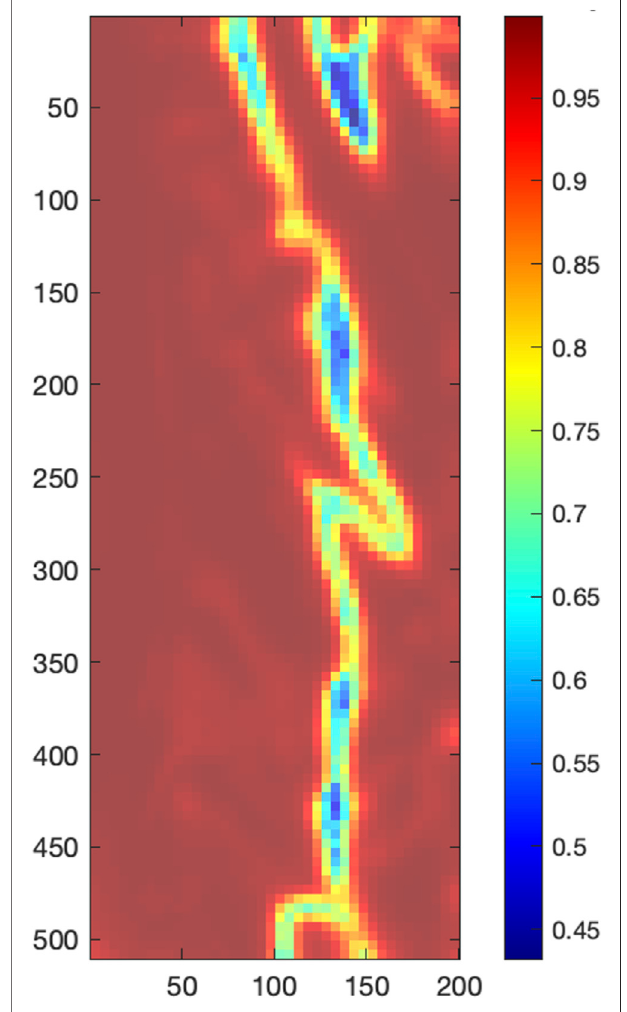
FIGURE 8 | Local correlation analysis, with the color bar indicating the average Pearson correlation coef fi cient of each central local SRVI to its 8